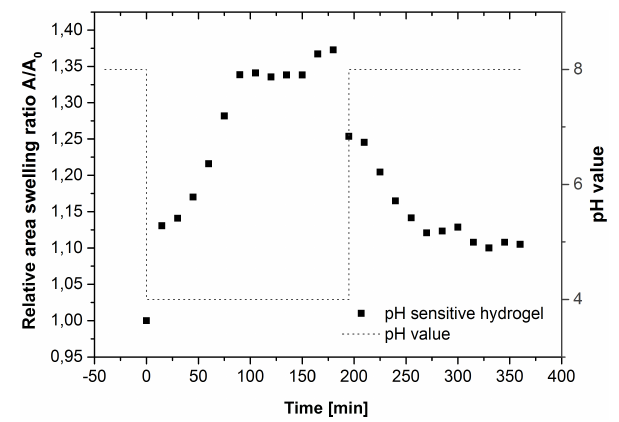
Figure 4. Relative area swelling ratio of pH-sensitive hydrogels in PBS while swelling from pH 8 to pH 4 and reverse deswelling.